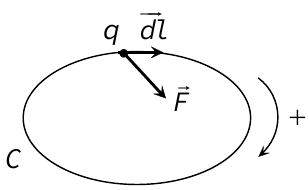
Figure 1: An oriented loop representing a